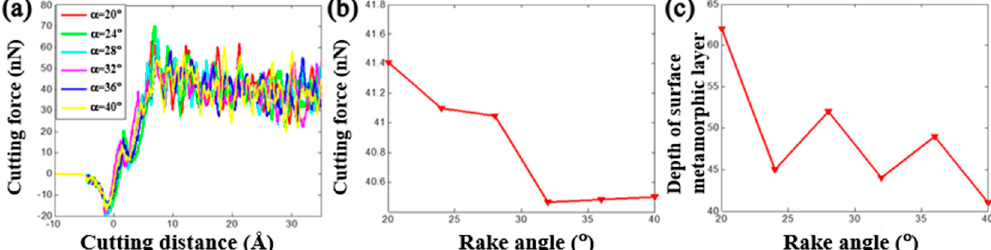
Figure 8. The cutting force and depth of the surface metamorphic layer obtained from QC by varying the tool rake angle. ( a ) Cutting force vs. the cutting distance under different tool rake angle α ; ( b ) evolution of the average cutting force when varying the tool rake angle and ( c ) evolution of the depth of the surface metamorphic layer when varying the tool rake angle.